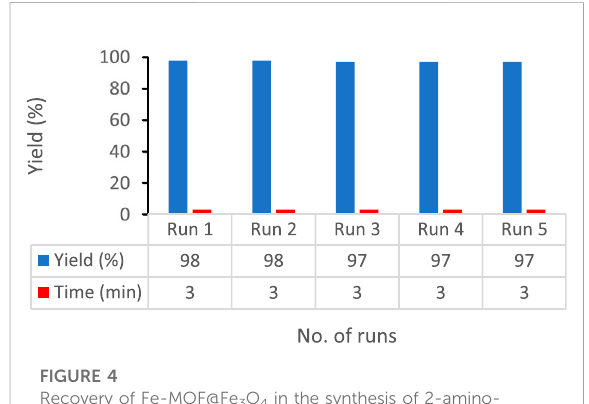
FIGURE 4 Recovery of Fe-MOF@Fe 3 O 4 in the synthesis of 2-amino-